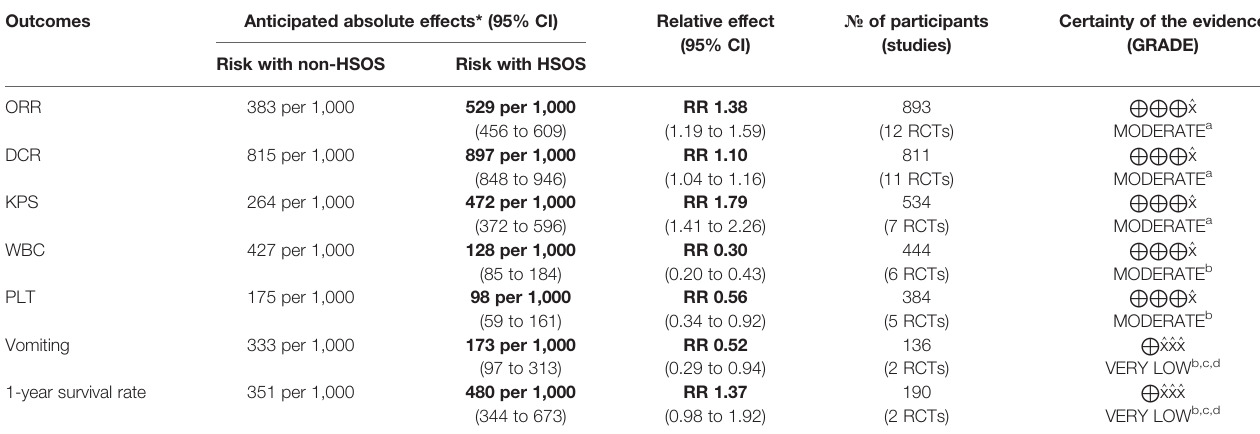
TABLE 3 | Summary of Fingings